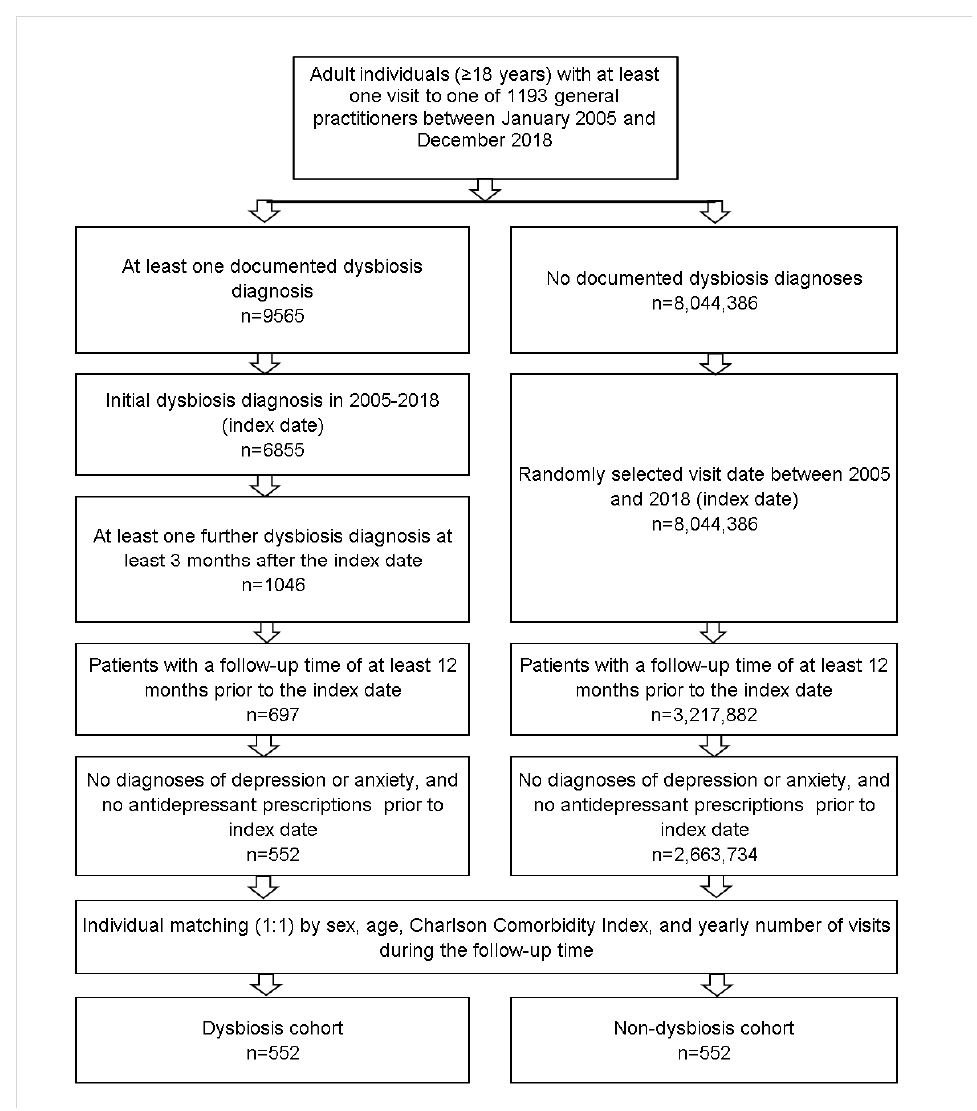
Figure 1. Selection of study patients.